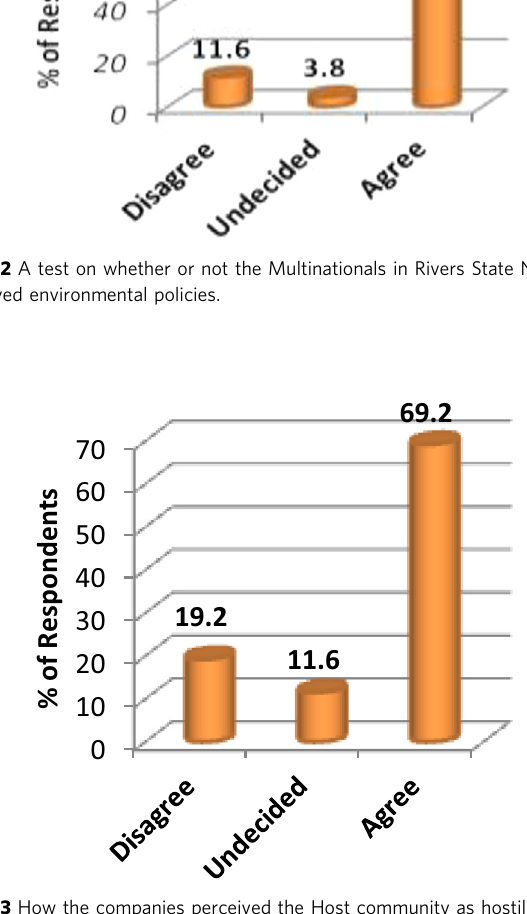
Fig. 3 How the companies perceived the Host community as hostile? Respondents who indicated that Host community is somewhat hostile.